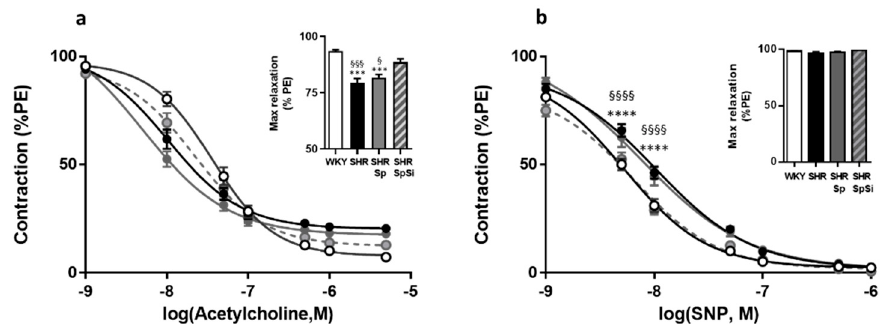
Figure 6. Effect of supplementation on vasorelaxant response of aorta. Cumulative dose response curves to Ach ( a ) and SNP ( b ) in aortic rings in WKY (white symbol), SHR (black symbol), SHR-Sp (grey symbol) and SHR-SpSi (dotted grey symbol). Bar graphs compare maximal relaxations for each antagonist in all groups. Data is expressed as percentage of PE-induced contraction show mean ± s.e.m ( n = 15). **** p < 0.0001, *** p < 0.001, vs. WKY; §§§§ p < 0.0001, §§§ p < 0.001, § p < 0.05 vs. SHR-SpSi. Table 2. Maximal responses (E max ) and sensitivity (EC 50 ) for the various agonists and antagonists of the contractile response on rat aorta.